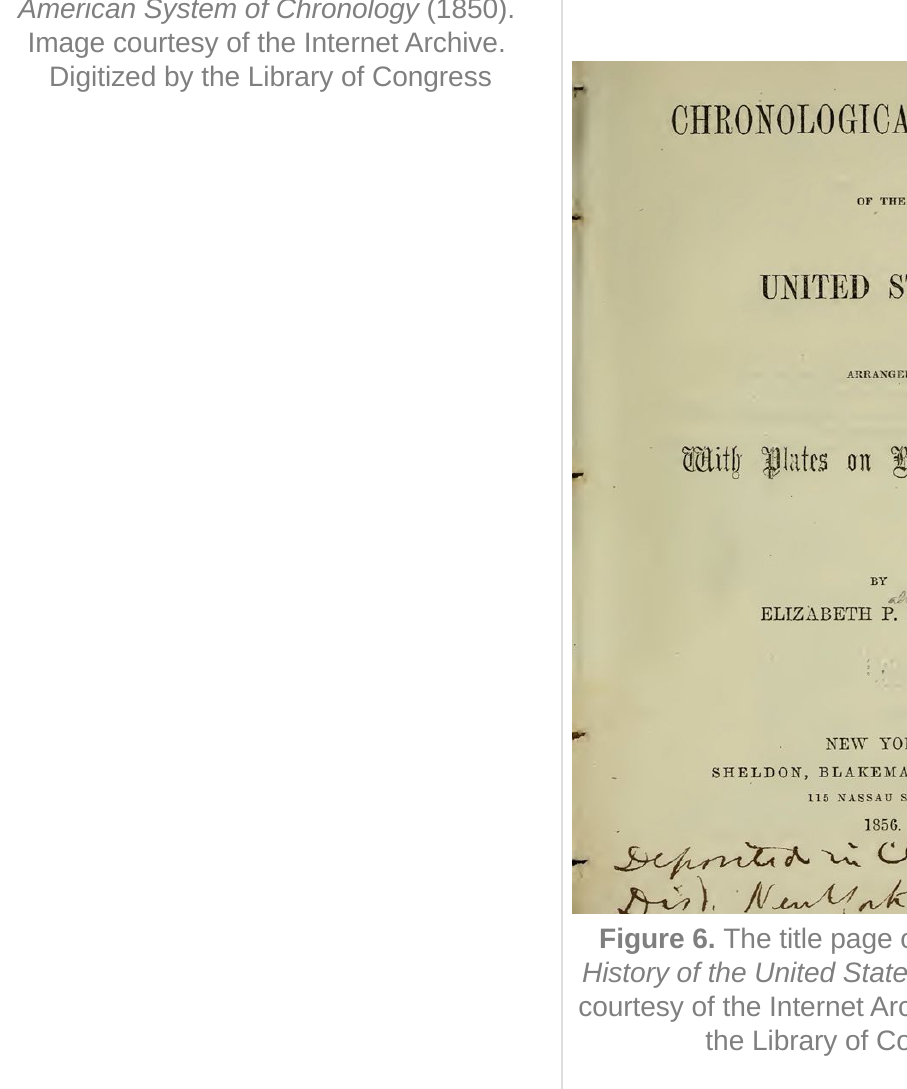
Figure 6. The title page of Chronological History of the United States (1856a). Image courtesy of the Internet Archive. Digitized by the Library of